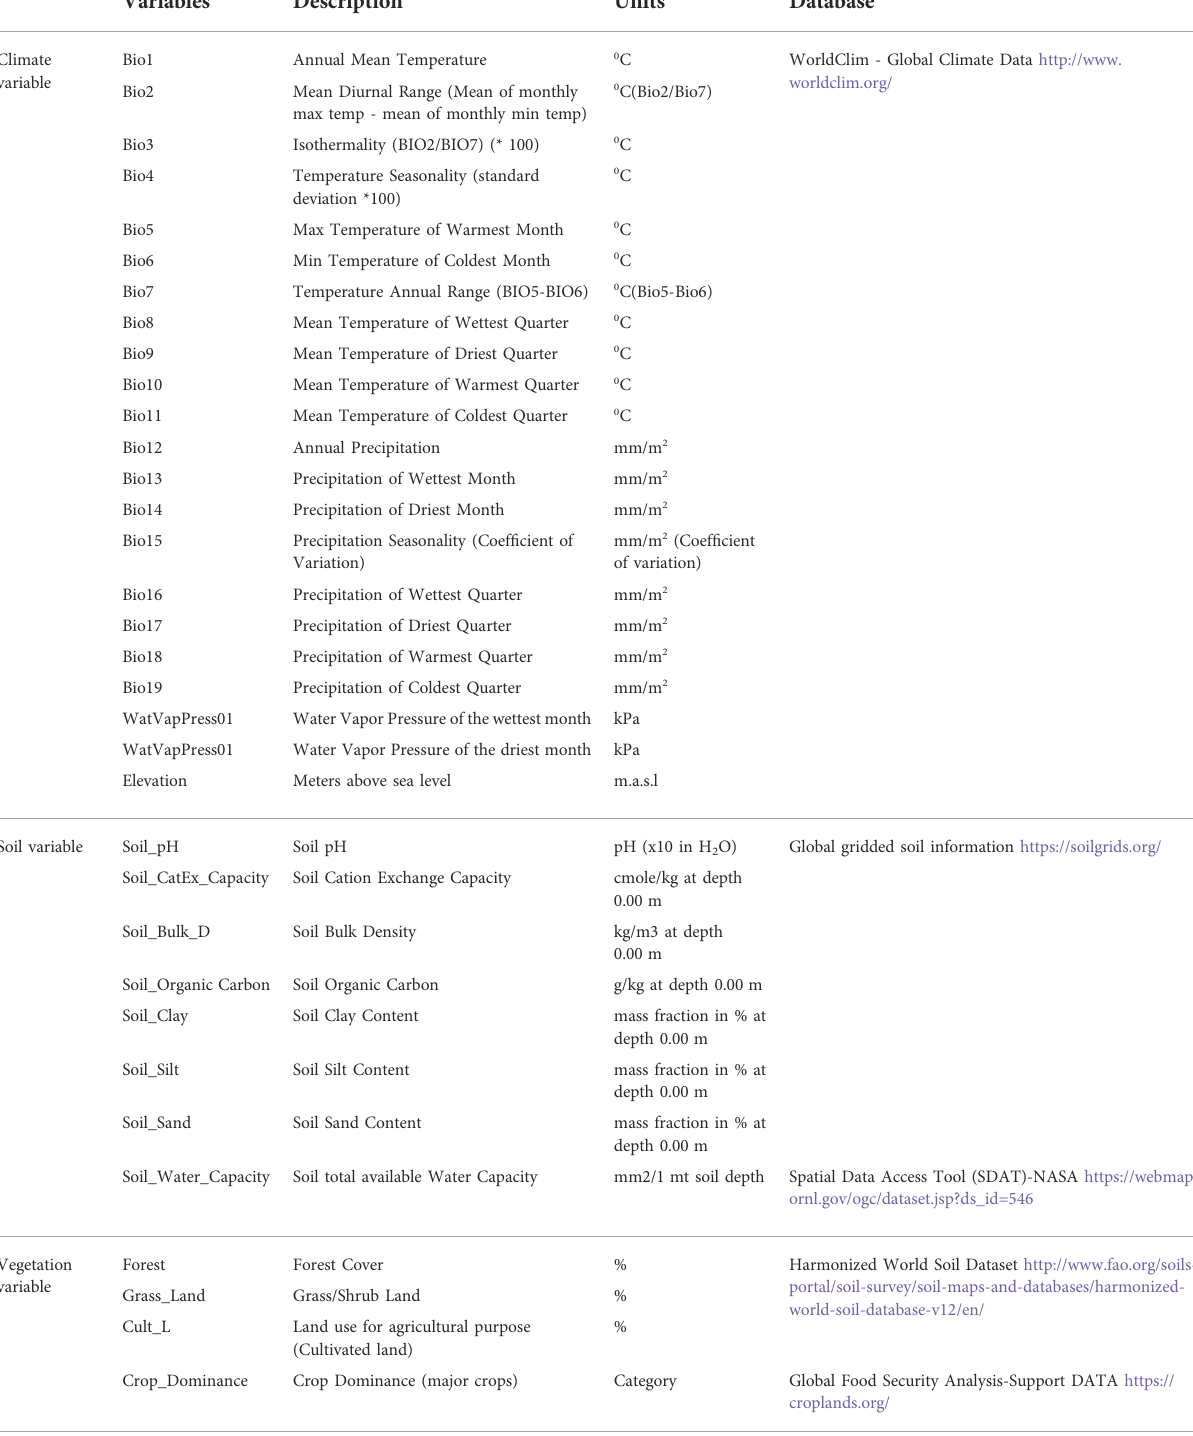
TABLE 2 Climatic variables